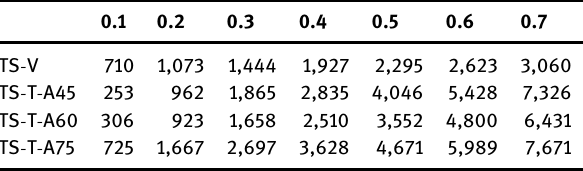
Table 5: Energy absorption of tested specimens ( J